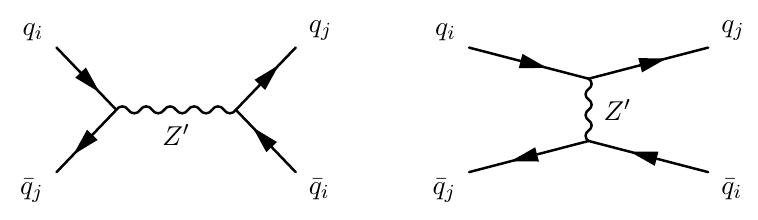
Figure 5 . Tree-level meson mixing via Z 0